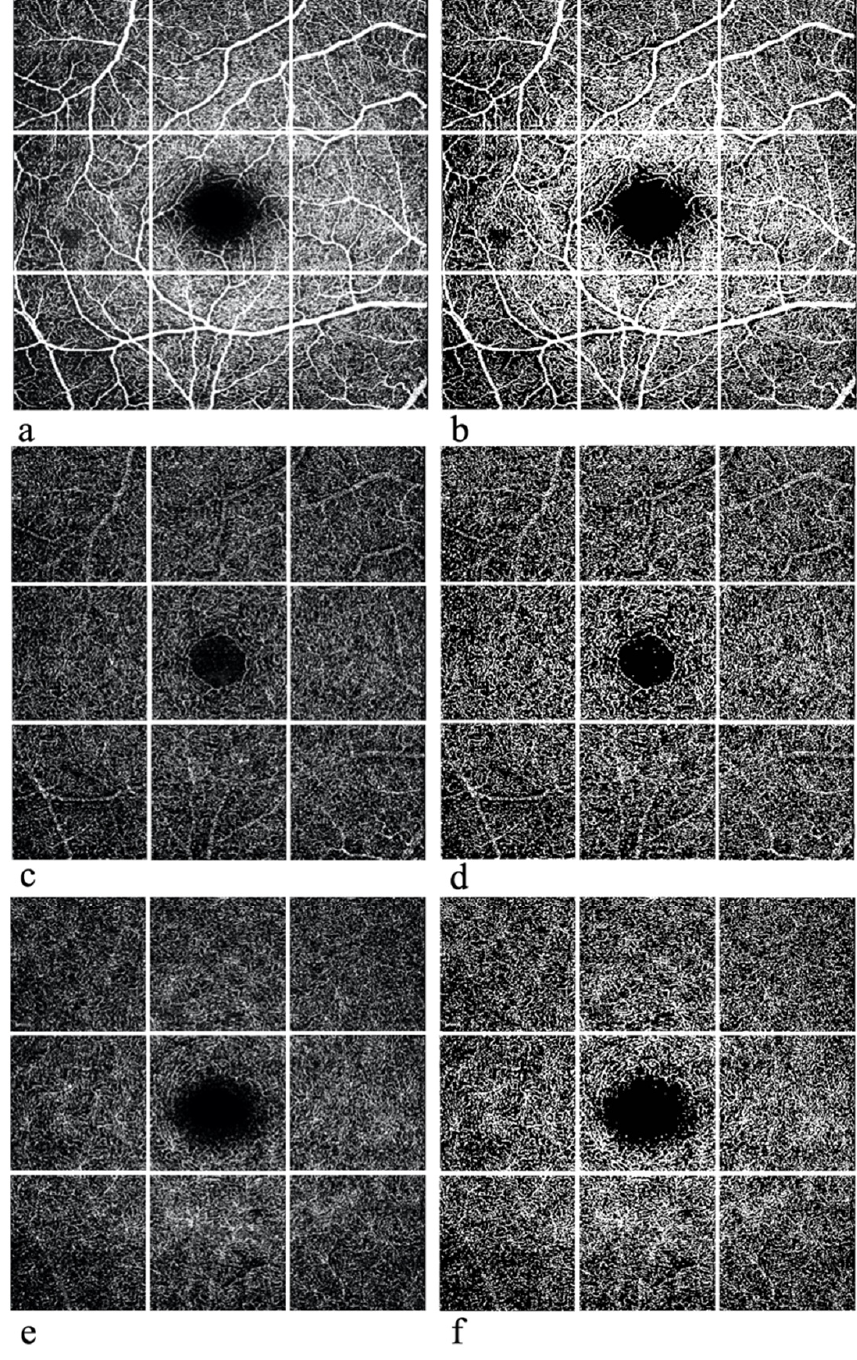
Figure 1. OCT-A scans of the SCP ( a , b ), ICP ( c , d ), and CP ( e , f ) before ( a , c , e ) and after ( b , d , f ) processing with Image J.